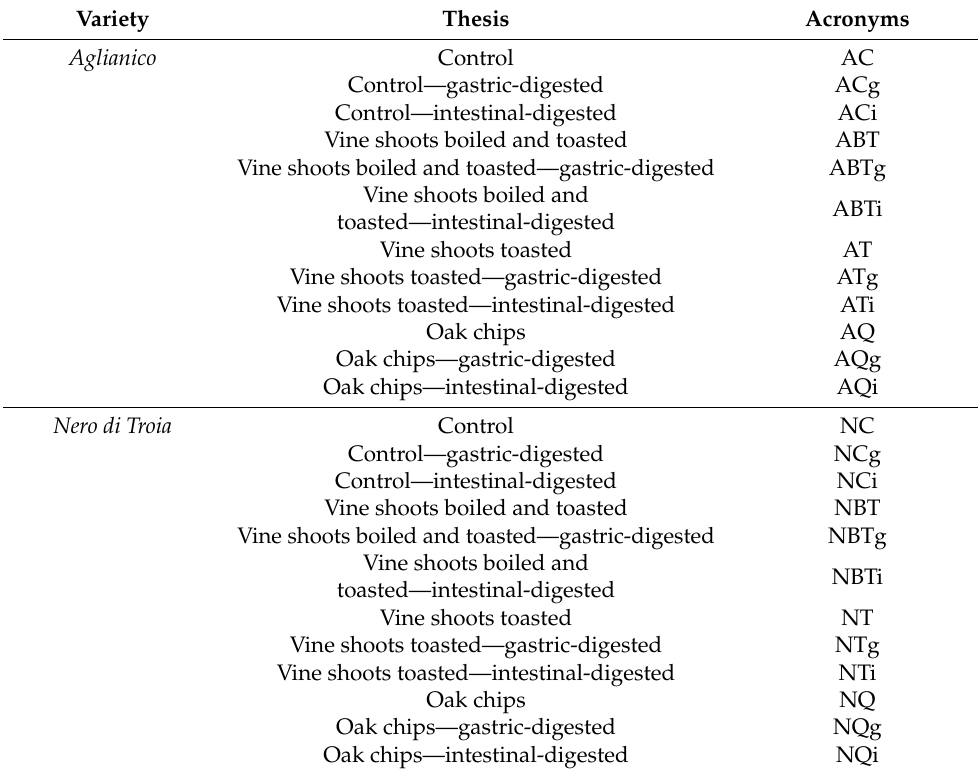
Table 1. Samples analyzed and acronyms used throughout the